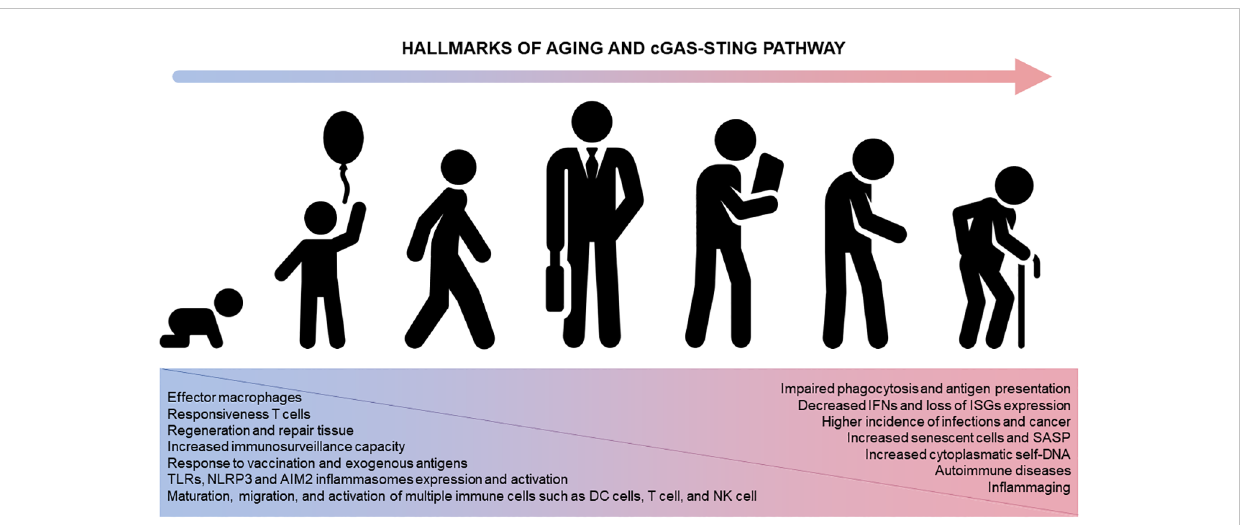
FIGURE 3 The cGAS-STING pathway and aging. STING participates in numerous immune system functions (left, blue). Physiological alterations in the immune system across lifespan ultimately compromise the immune system homeostasis impacting different diseases and disorders (right, pink). AIM2, absent in melanoma 2; DC, dendritic cells; ISG, IFN-stimulating genes; IFN, interferon; NK, natural killer cells; NLRP3, nucleotide-binding oligomerization domain-like receptor protein 3; TLR, Toll-like